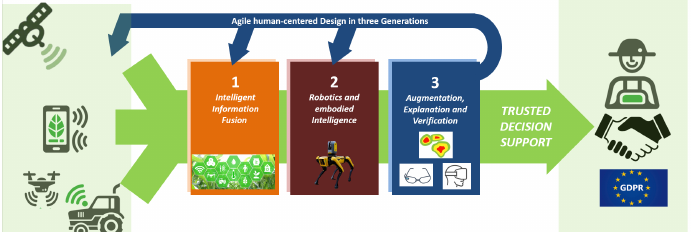
Figure 9. 3 × 3: The three frontier research areas with agile human-centered design in three genera- tions. G1: testing existing technology, G2: adapting existing technology, G3: advanced adaptation going beyond